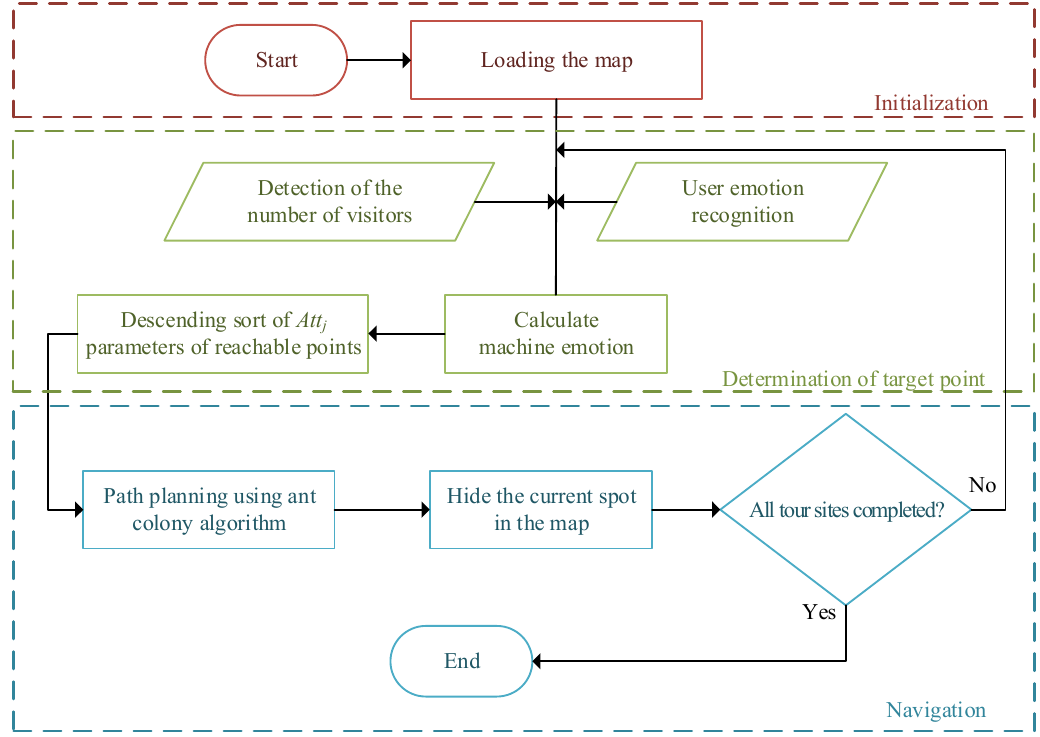
Figure 4. Navigation strategy process based on machine emotion.